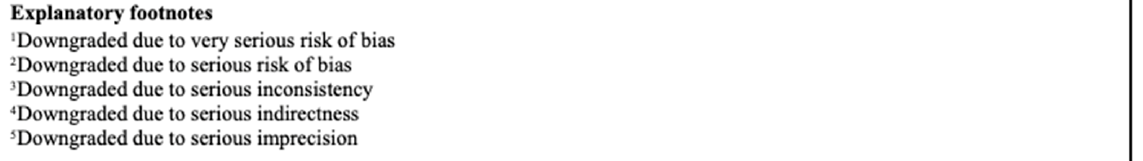
Figure 11. Summary of findings for long-term PPD reduction following the use of systemic antibiotics adjunctive to subgingival debridement.